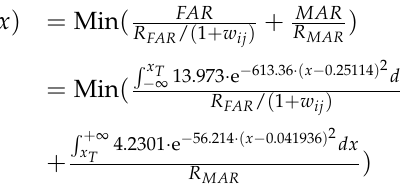
= R = 0.01, are input into FAR MAR